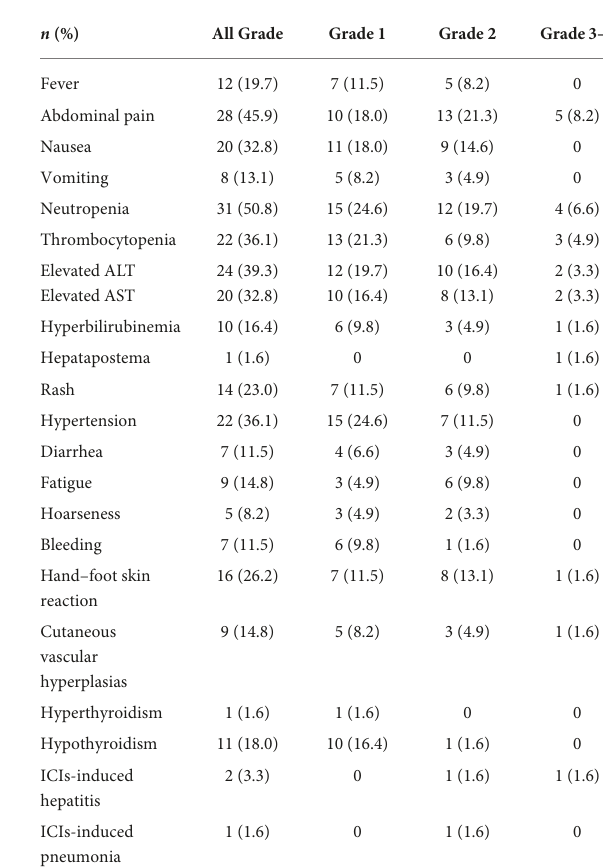
TABLE 5 Summary of adverse